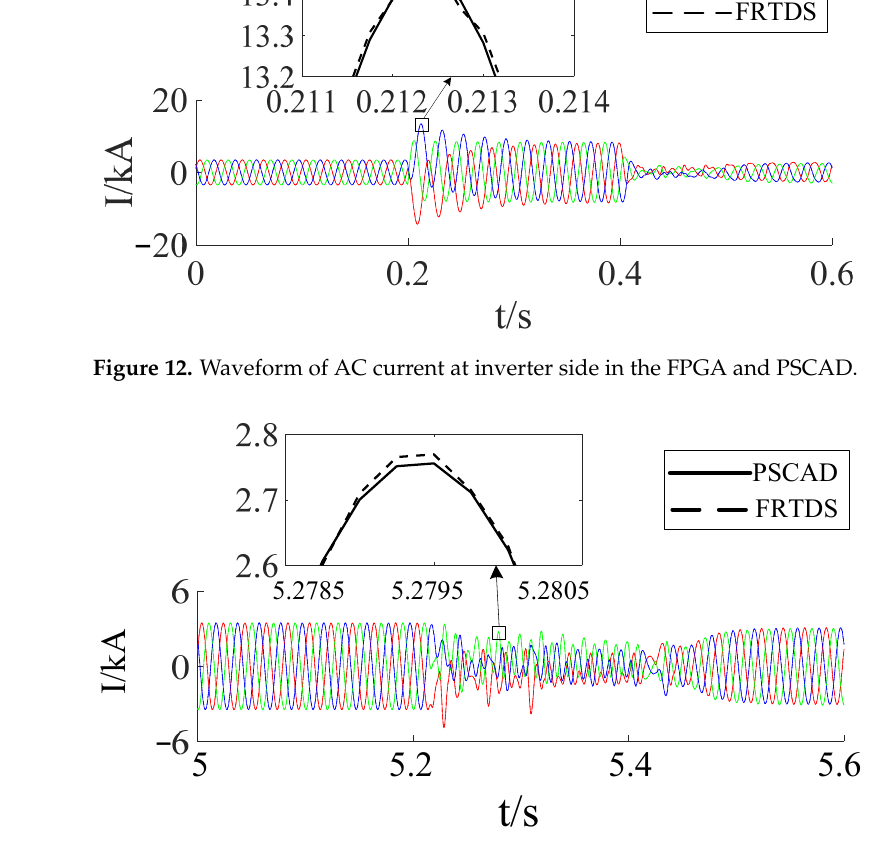
Figure 13. Waveform of AC current at inverter side in the FPGA and PSCAD.